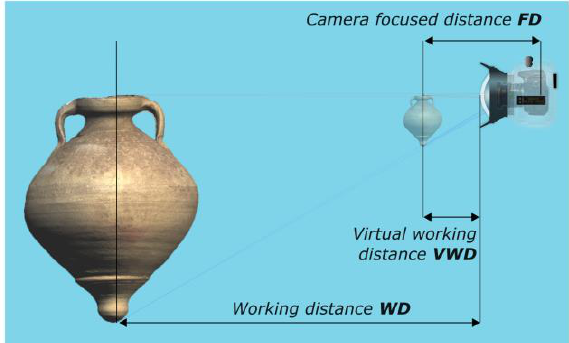
Figure 6. Effect of a dome port: a subject located at a working distance (WD) appears smaller and much closer to the camera - virtual working distance